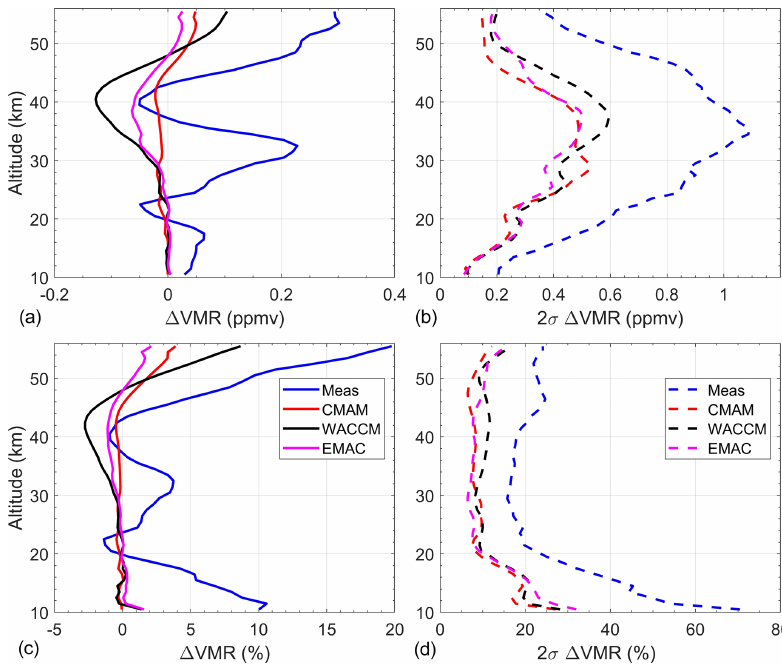
Figure 1. Measured and simulated mean differences (a, c) between ACE-FTS and OSIRIS O 3 and the corresponding 2 σ variability (b, d) . Profiles for all available times and latitudes with coincidence criteria of within 6h and 500km are used. Results shown for the differ- ences (a, b) and relative differences (c, d)